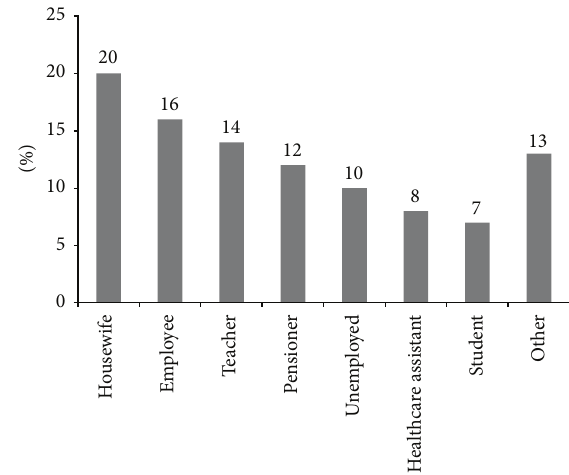
Figure 2: Occupational features in the group of patients self- reporting electromagnetic hypersensitivity (EHS, 𝑛 = 153 ). Data are expressed as percentage of the total number of